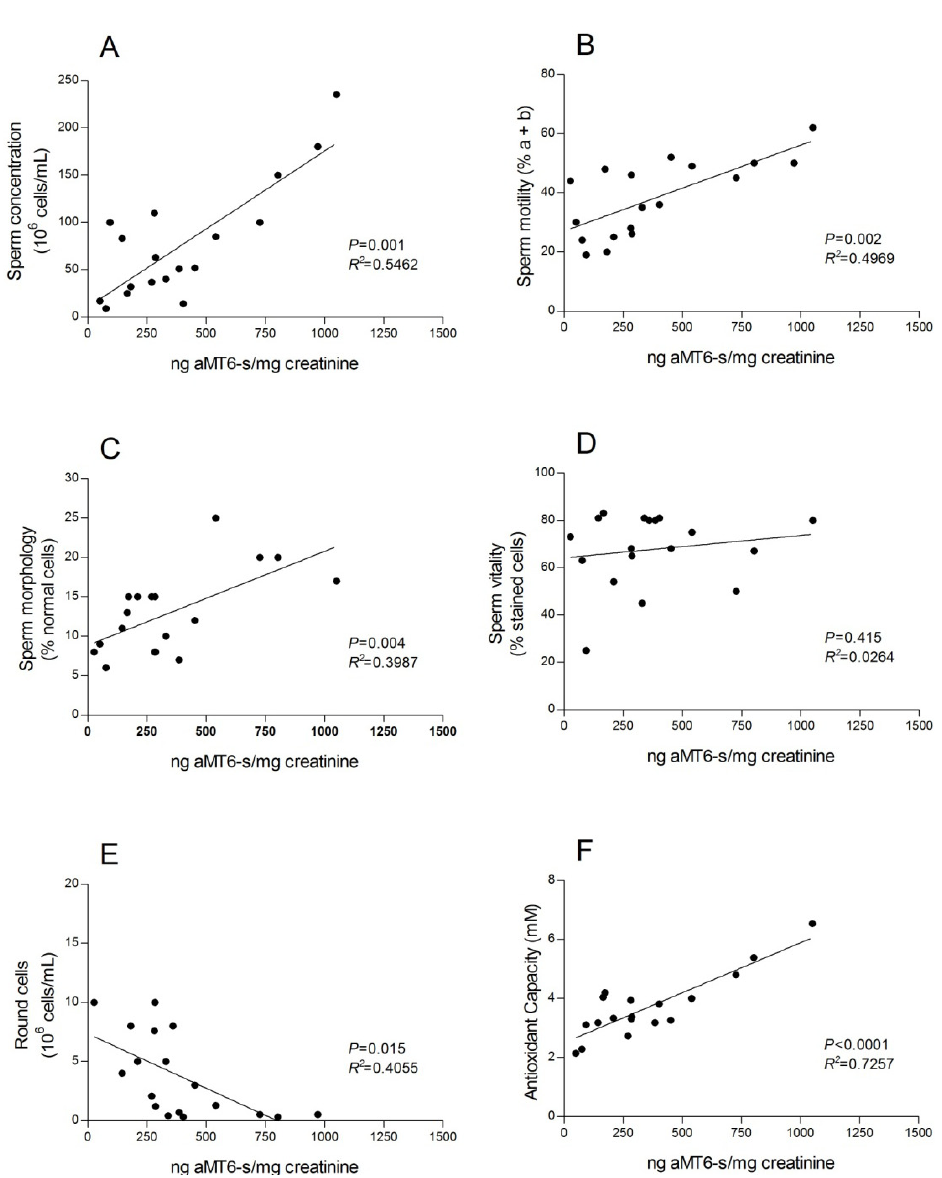
Figure 12. Correlations between urinary 6-hydroxymelatonin sulfate (aMT6-s), a major hepatic metabolite of melatonin, in the first urine morning void and various human sperm parameters in 20 adult males (20–40 years age). The semen samples were collected by masturbation after 4–5 days of sexual abstinence. The following parameters correlated positively with the concentration of urinary aMT6-s, which was taken as an index of endogenous melatonin levels: sperm concentration ( A ), sperm motility ( B ), sperm morphology ( C ), sperm vitality ( D ), and the total antioxidant status of the urine (estimated using the ABTS assay). There was a negative correlation between urinary aMT6-s and the number of round spermatids (cells) in the semen ( E ). Data from Espino et al.